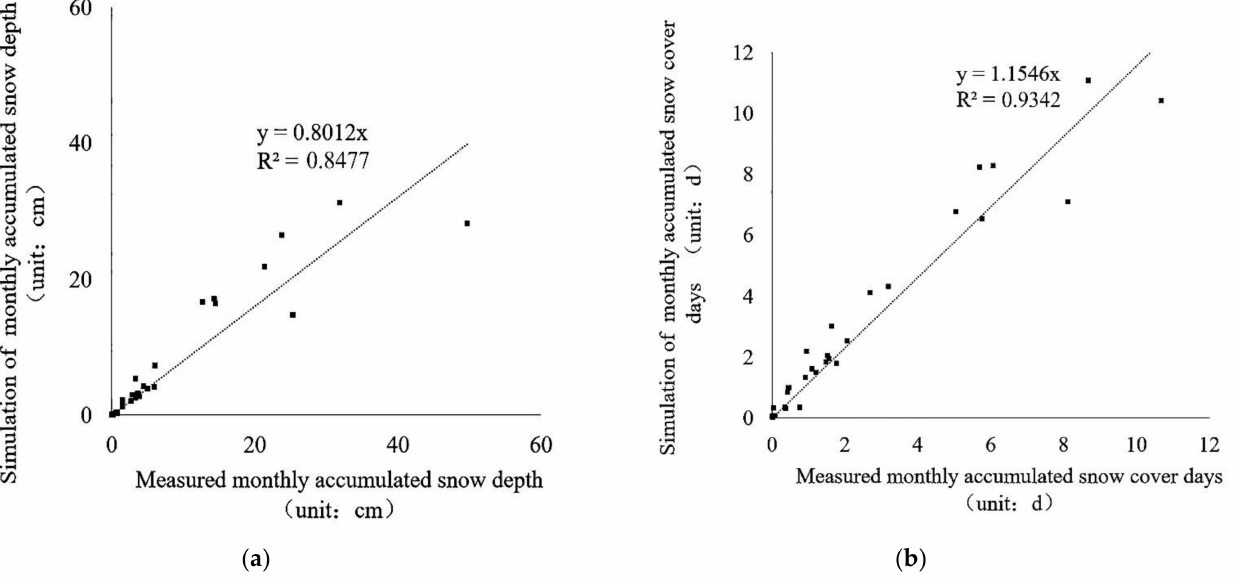
Figure 10. Correlation of observed and simulated values at the provincial scale for: ( a ) cumulative snow depth, and ( b ) cumulative snow cover